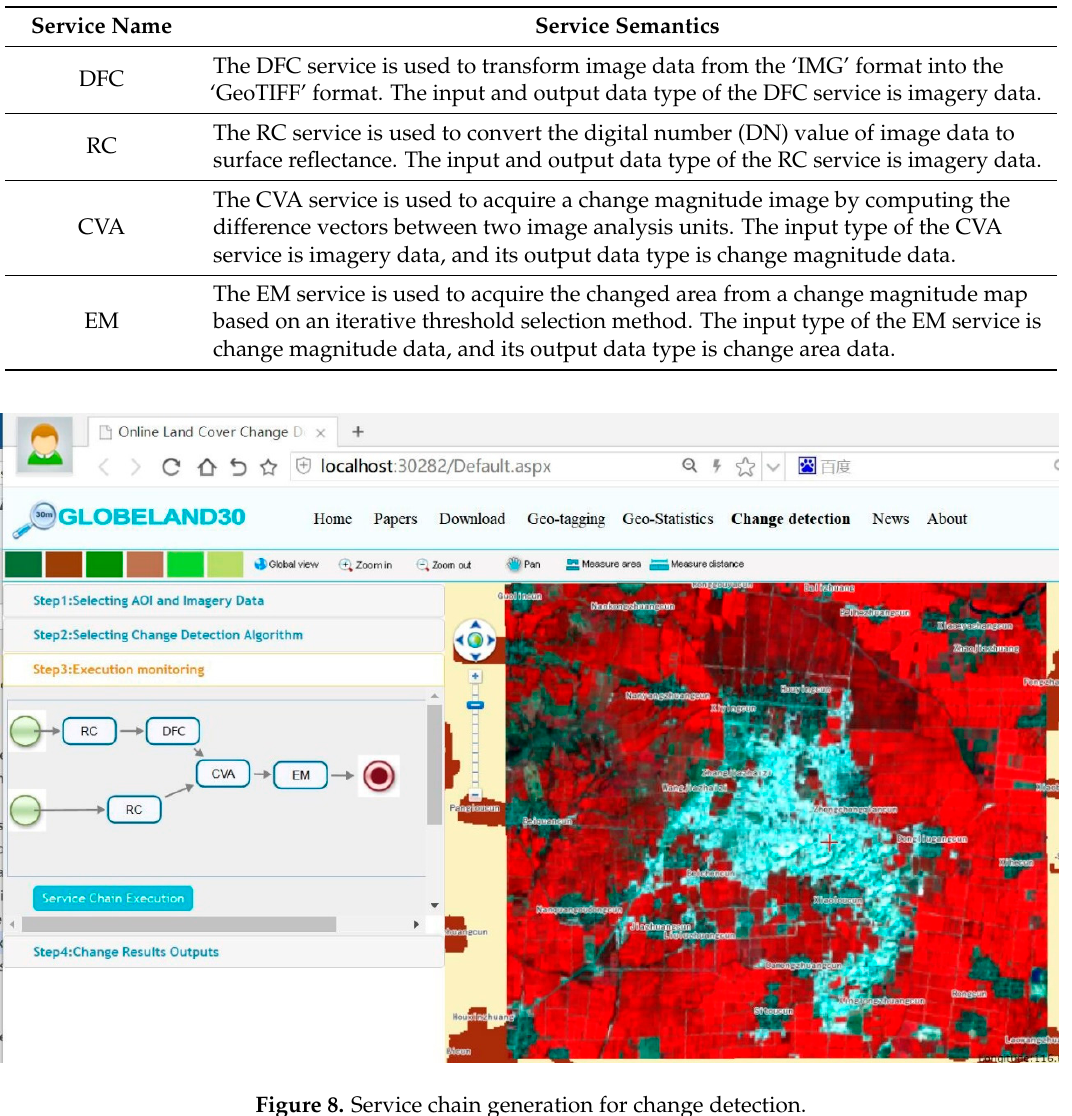
Table 5. Service semantics of the services in the service chain. DFC: data format conversion, RC: radiometric correction, CVA: change vector analysis, and EM: expectation maximization.